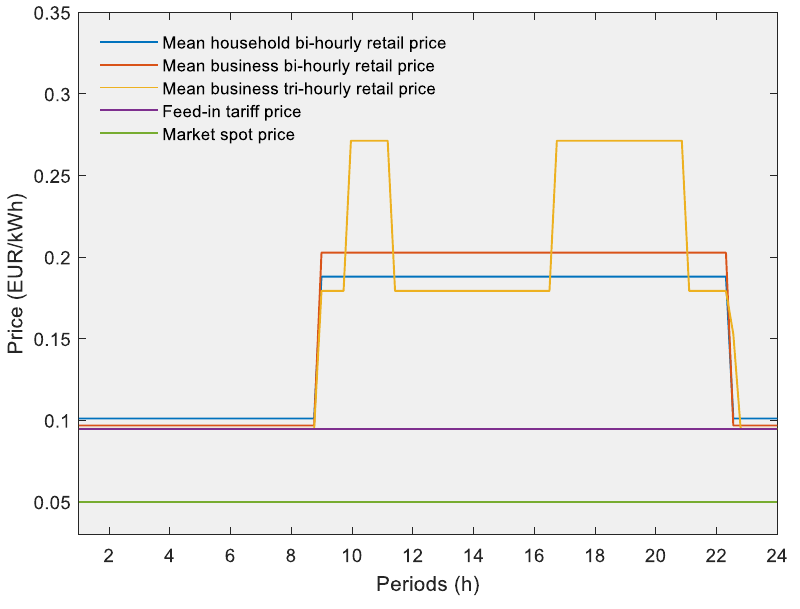
Figure 3. Electricity prices.